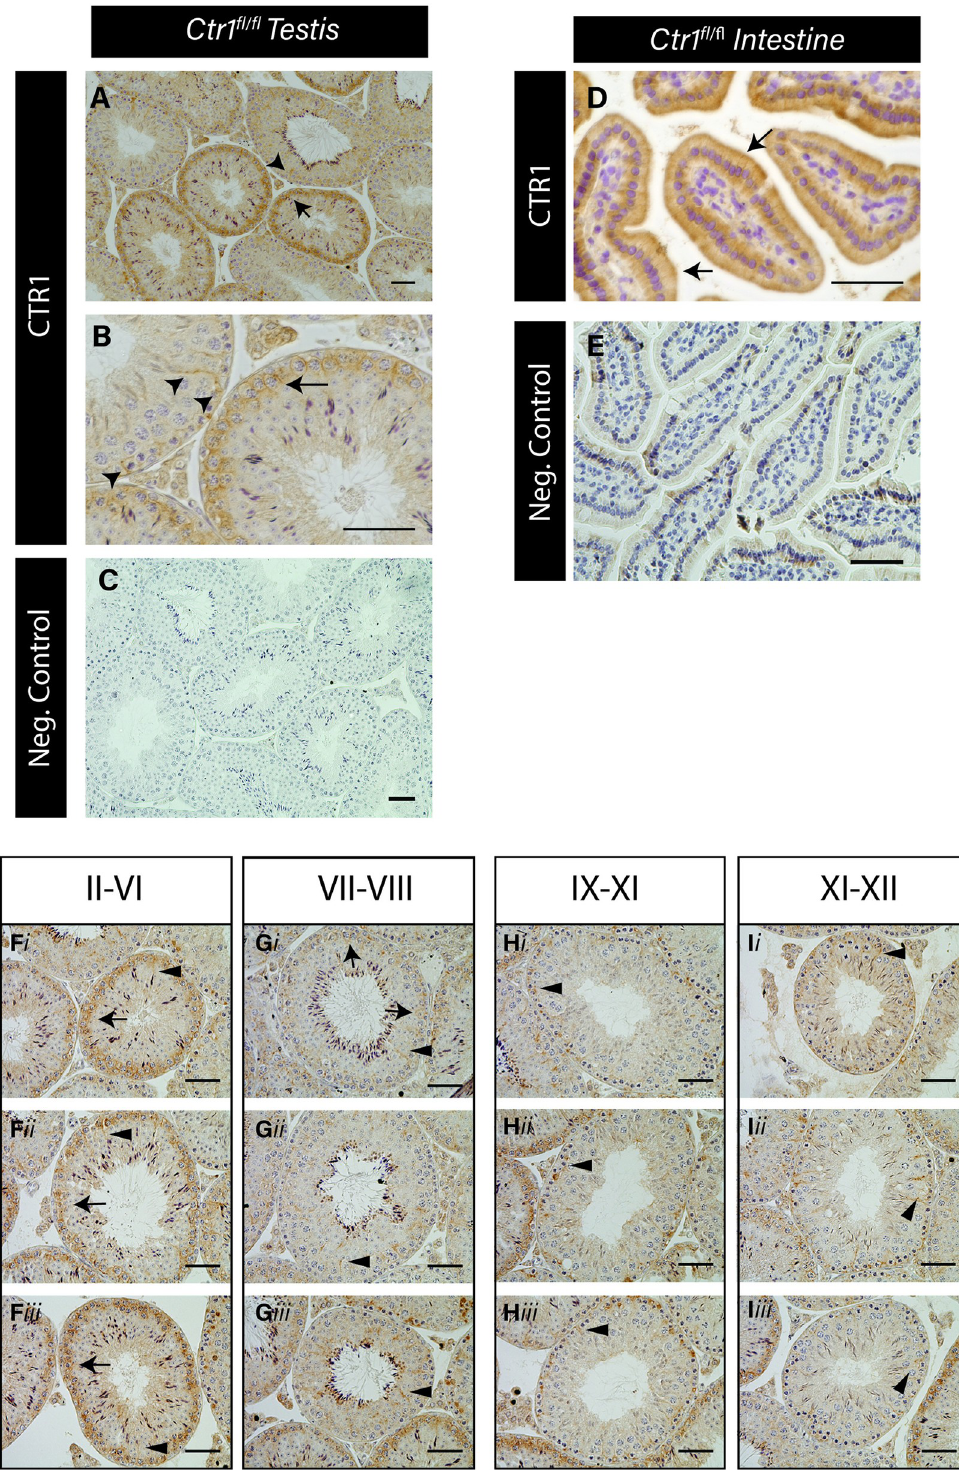
Fig 1. CTR1 is expressed in pachytene spermatocytes and Sertoli cells in a stage specific manner. Immunohistochemical localization of CTR1 in adult (PND 60) Ctr1 fl/fl mouse testis cross sections (A, B). Arrow indicates expression on primary pachytene spermatocytes. Arrowheads indicate SC apical and basal cytoplasm. CTR1 expression on the apical surface of the epithelial cell in the intestine of adult mice indicated by arrows (D). Negative secondary only control of testis (C) and